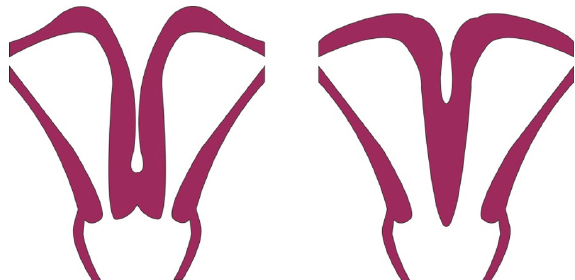
Figure 5: Didelphic uterus (left), bicornuate bicollis uterus (right), courtesy of Kyle